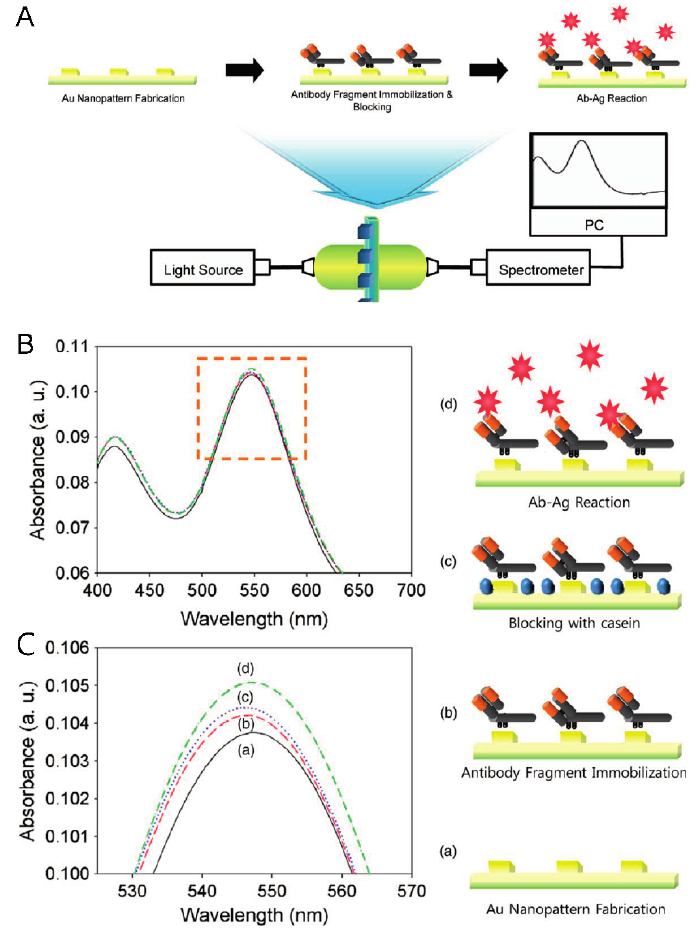
Figure 3. Optical detection of HIV-1 virus based on LSPR mechanism. ( A ) Schematic representation of the immunoassay configuration with LSPR method for the quantitative detection of HIV-1 particles; ( B ). Optical characteristics (change in absorbance peak) based on the: ( a ) bare Au nanopattern on ITO substrate; ( b ) fragmented antibody immobilized layer; ( c ) blocking with casein; ( d ) HIV-1 VLPs immuno reacted layer. Figure reproduced with permission from [40], © 2013